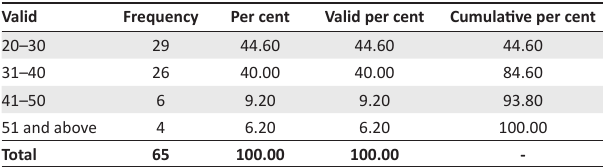
TABLE 1: Frequencies of participants’ age.